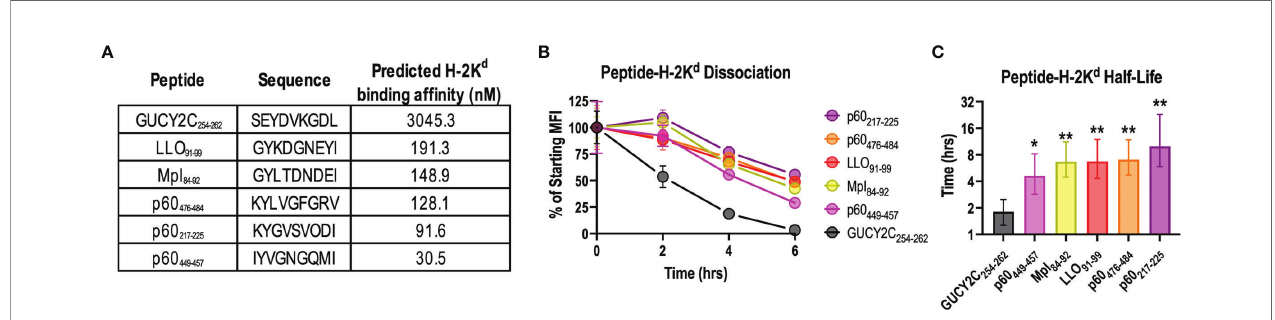
FIGURE 3 | The GUCY2C 254-262 -H-2K d complex is less stable than peptide-H-2K d complexes derived from Lm epitopes. (A) The predicted binding af fi nity of GUCY2C 254-262 peptide for H-2K d was compared to that of all known Lm-speci fi c H-2K d -restricted epitopes using NetMHCPan4.0. (B, C) The stability of peptide-H- 2K d complexes was measured using the TAP-de fi cient cell line, RMA-S H-2K d . (B) The normalized speci fi c mean fl uorescence intensities (MFI) are shown. Error bars indicate mean +/- SEM of technical replicates. (C) Half-lives (t 1/2 ) were determined by nonlinear regression of (B) . Error bars indicate computed t 1/2 +/- 95% con fi dence intervals. Statistical comparisons were made to GUCY2C 254-262 by extra sum-of-squares F Test with Bonferroni correction. Data are representative of two experiments. *P < 0.05; **P